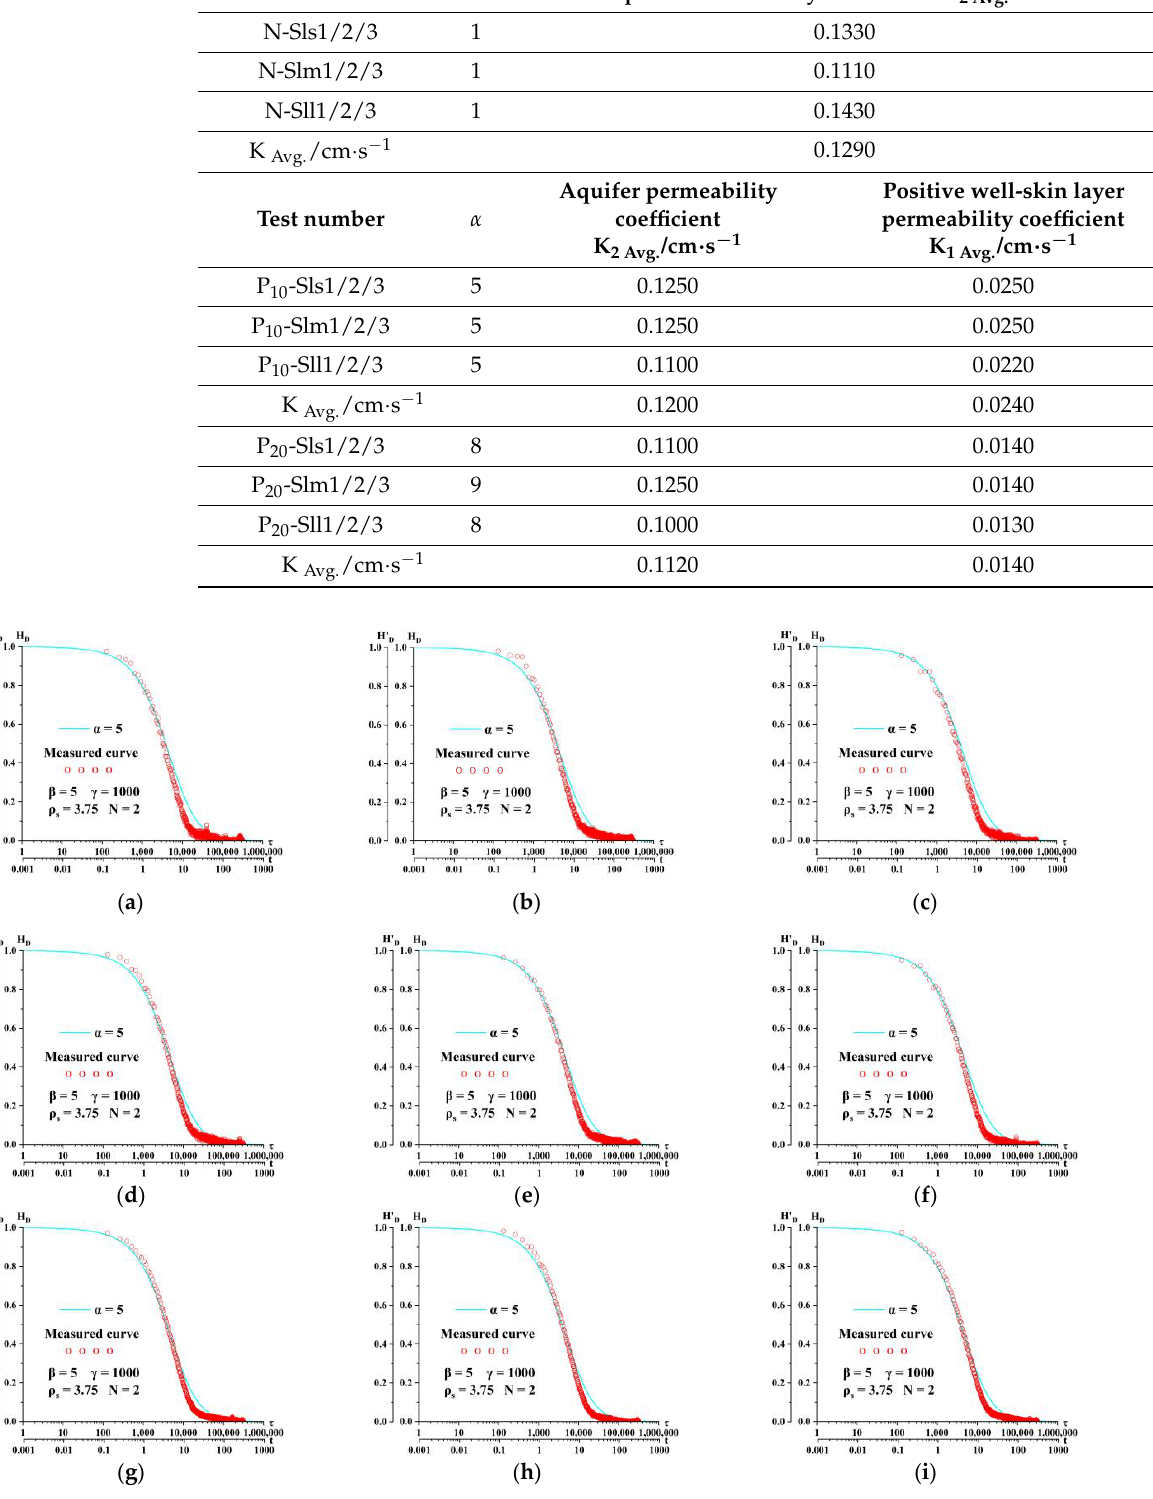
Figure 8. Curve fitting diagram between measured data from slug test and HWS model standard curve under model conditions of ρ s = 3.75. ( a ) P 10 -Sls1. ( b ) P 10 -Sls2. ( c ) P 10 -Sls3. ( d ) P 10 -Slm1. ( e ) P 10 -Slm2. ( f ) P 10 -Slm3. ( g ) P 10 -Sll1. ( h ) P 10 -Sll2. ( i ) P 10